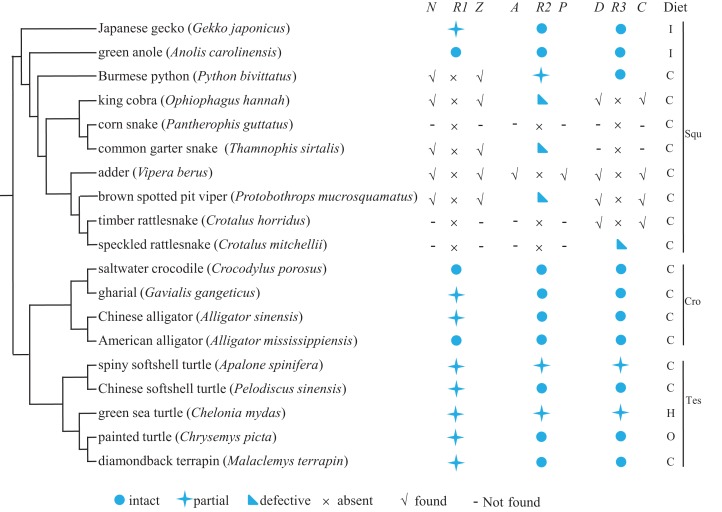
The umami/sweet taste receptor gene functionality of 19 reptiles and their dietary preferences.The distribution of flanking genes are also shown when Tas1r gene is absent. The species phylogeny was drawn from the TimeTree (http://www.timetree.org/) and referred to Zhong et al. (2017) and Pyron, Burbrink & Wiens (2013). N, Z, A, P, D, C denotes the neighboring gene Nol9, Zbtb48, Aldh4a1, Pax7, Dvl1, and Cptp, respectively, and R1, R2, R3 indicates Tas1r1, Tas1r2, Tas1r3. Squ, Cro, Tes denotes squamata, crocodylia and testudines, respectively.